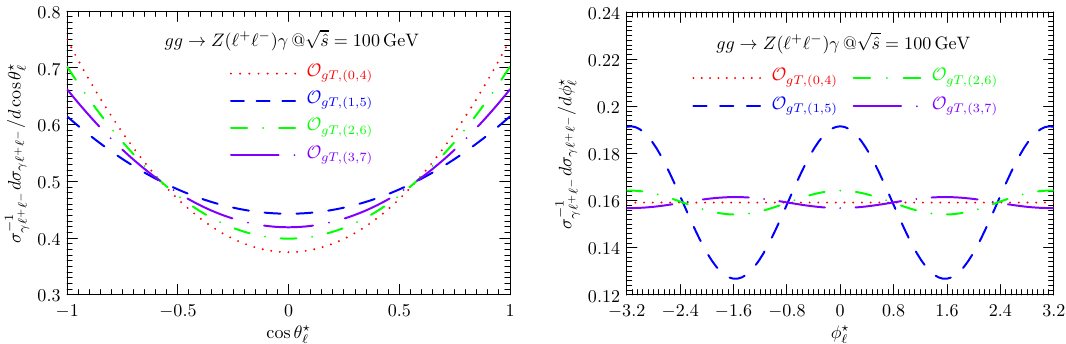
Figure 11 . The normalized differential cross sections in the polar ( θ ? of the outgoing lepton when the gluon-gluon collision energy